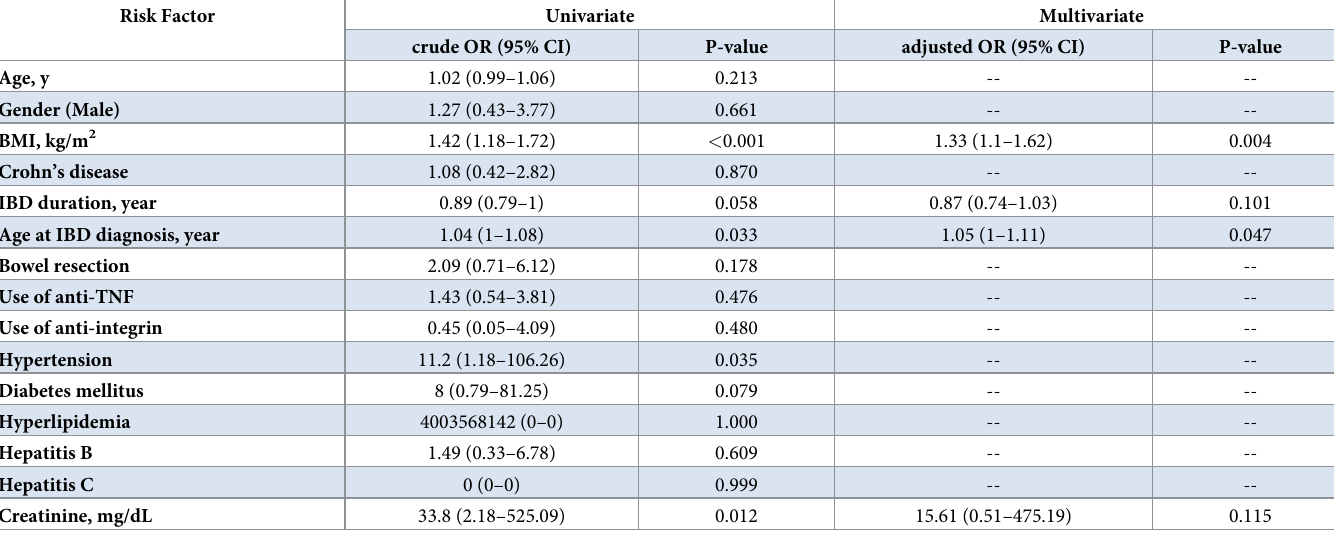
Table 3. Multivariable analysis of factors associated with